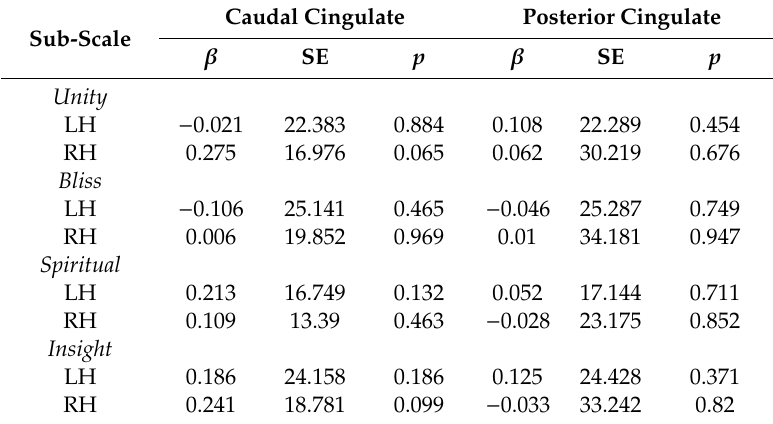
Table 3. Caudal and posterior cingulate thickness do not predict psilocybin emotional experience.